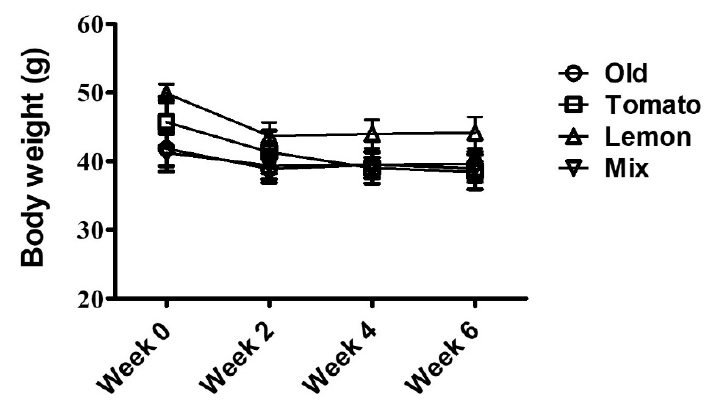
Figure 3. There was No change in body weight during the study